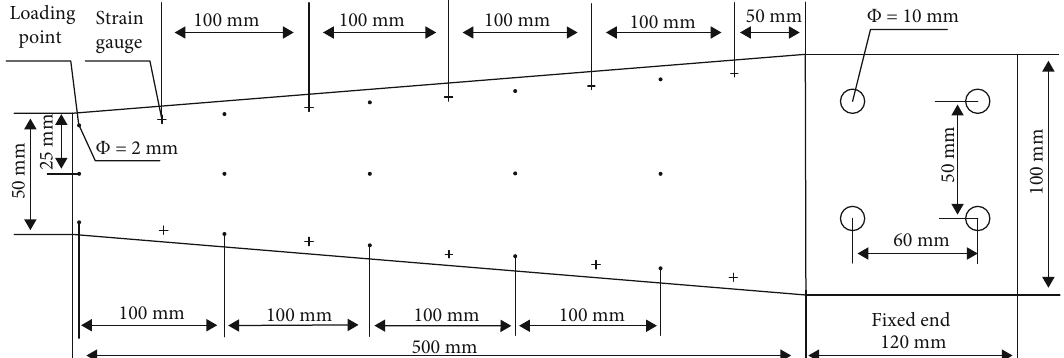
Figure 2: Airfoil cantilever structure diagram.